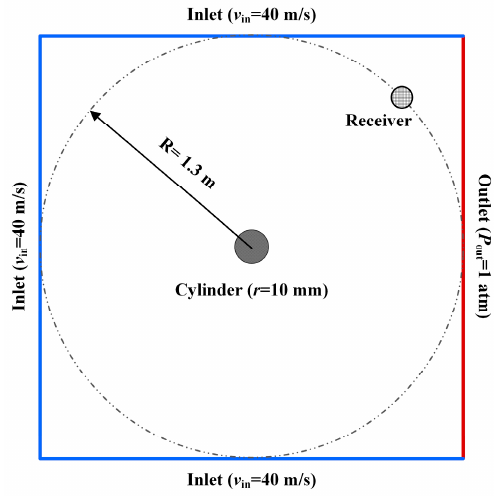
Figure 5. The validation case of a 2D cylinder (not to scale).